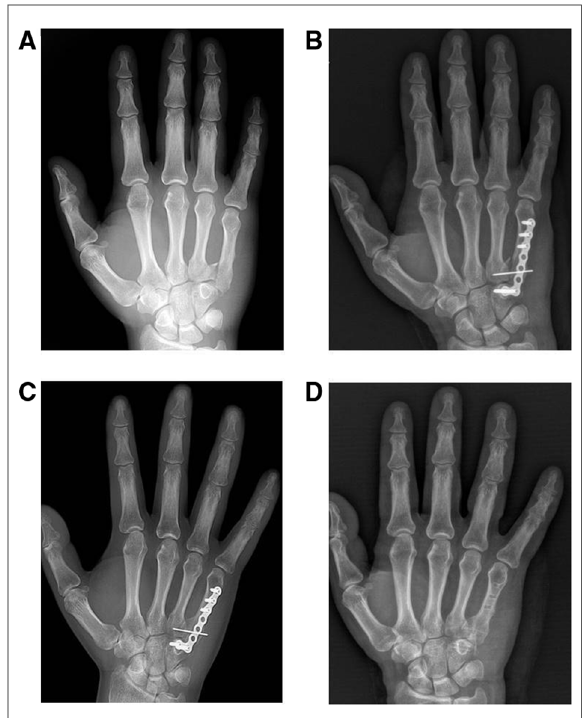
FIGURE 1 The treatment process of a patient with fracture-dislocation of the fi fth carpometacarpal joint of the right hand. ( A ) The preoperative anteroposterior x-ray. ( B ) The postoperative anteroposterior x-ray the day after internal fi xation surgery. ( C ) The postoperative anteroposterior x-ray 10 weeks after internal fi xation surgery. ( D ) The postoperative anteroposterior x-ray the day after internal fi xation removal surgery.